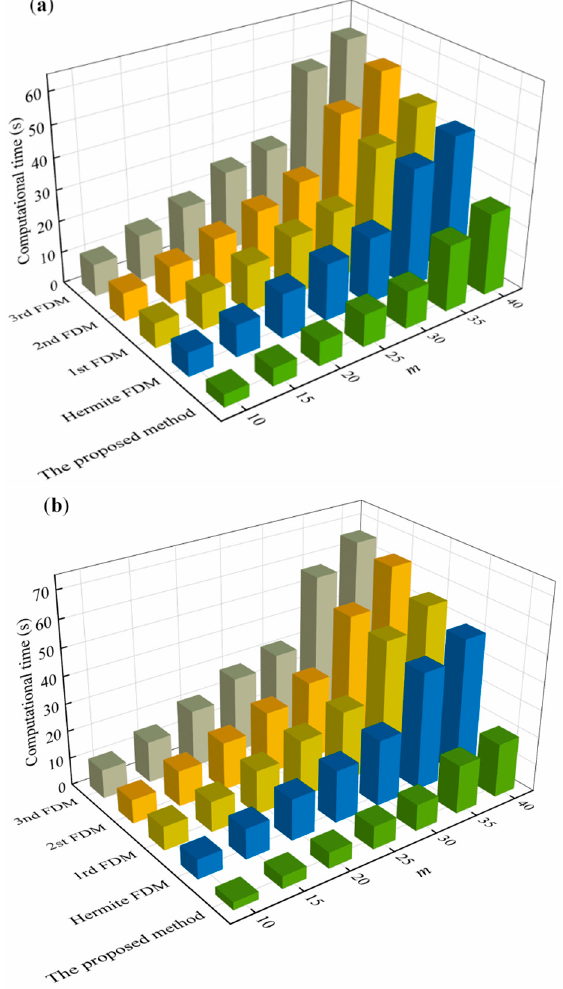
Figure 5. Comparison of calculated time among the 0th SDM, 1st FDM, 2nd FDM, 3rd FDM, Hermite FDM, and the proposed method with different radial immersion ratios. ( a ) Calculated time at a/D = 0.1 and ( b ) Calculated time at a/D = 1.